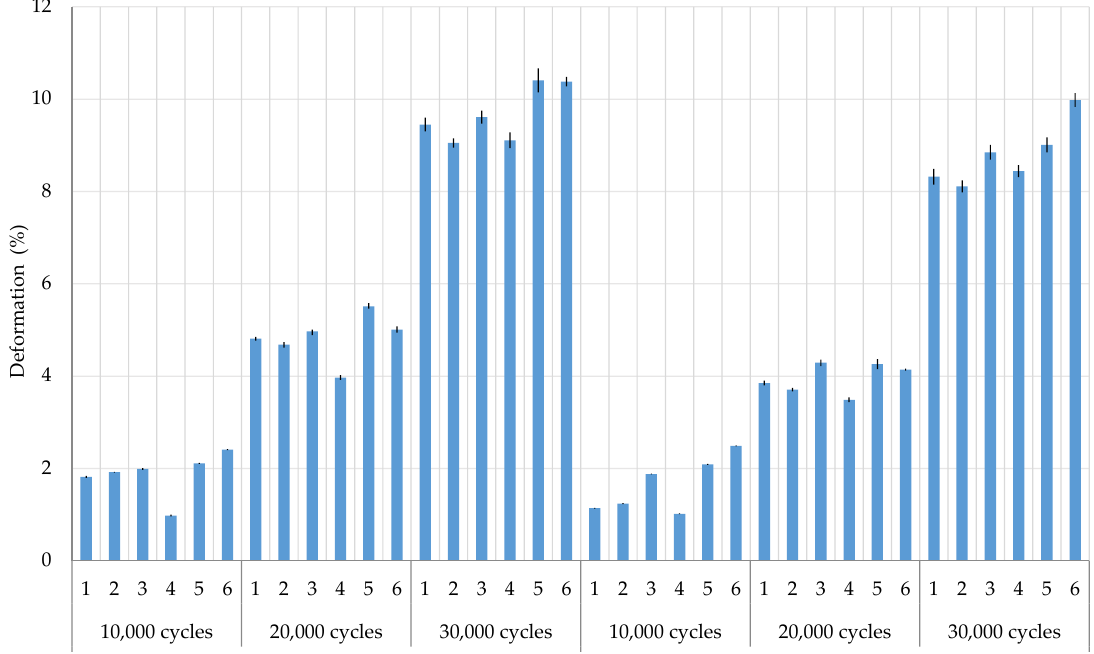
Figure 6. Woven fabric deformations according to the number of cycles with error display.